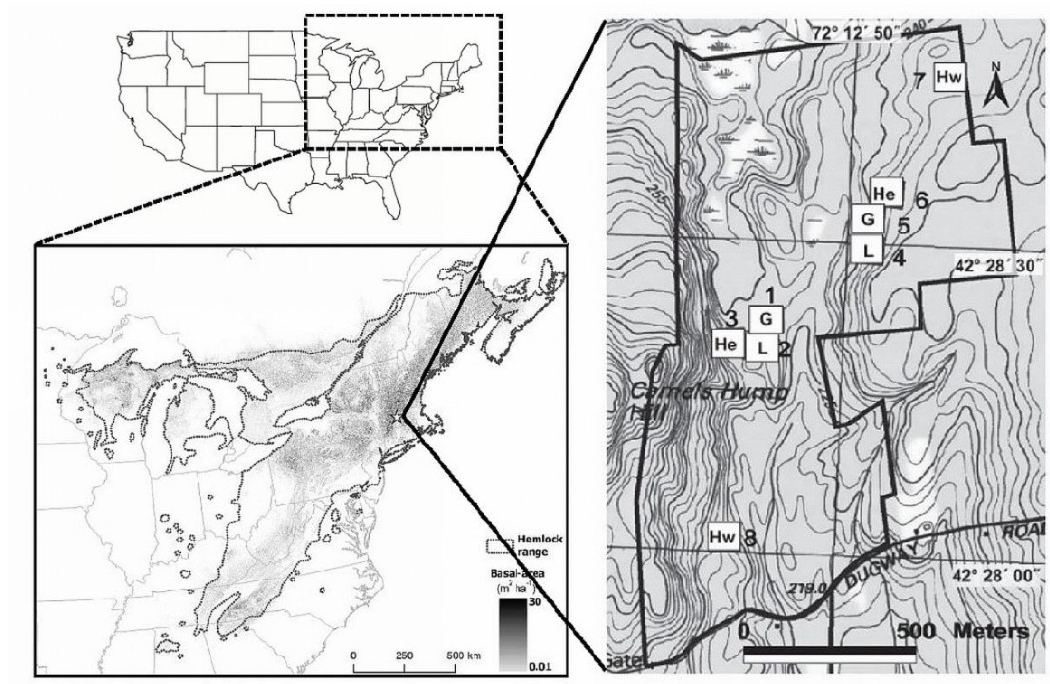
Figure 1. Distribution (grey shading indicating basal area in m 2 /ha) of eastern hemlock ( Tsuga canadensis ) in eastern North America; location of the Harvard Forest (star in regional map at lower left); and layout of the Harvard Forest Hemlock Removal Experiment. In the right-hand panel, the treatments applied to each 0.81-ha experimental plot are abbreviated: He—unmanipulated hemlock control; Hw—unmanipulated hardwood control; G—bark and cambium of all hemlock seedlings, saplings, and trees girdled with chainsaws and knives; L—all merchantable hemlock (≥20 cm diameter at breast height (DBH)) and some merchantable hardwoods and white pines ( Pinus strobus ) cut and removed from the site [61].